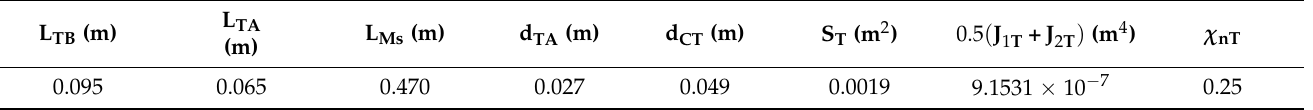
Table 1. Geometry characteristics of the tulip [29].